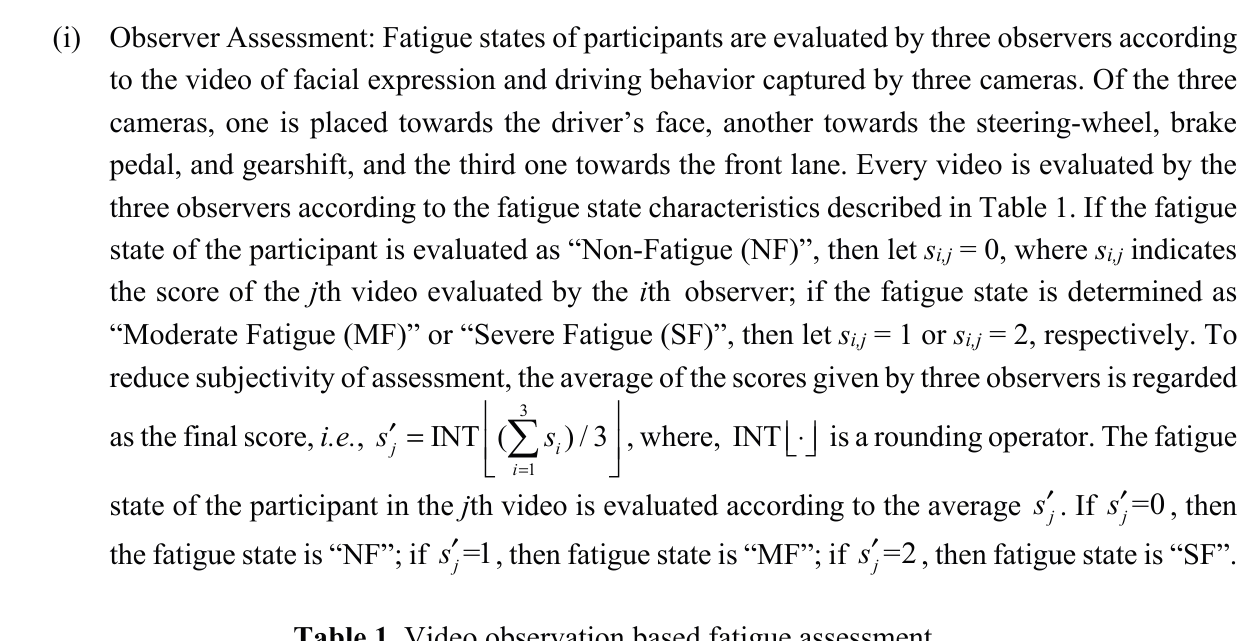
Table 1. Video observation based fatigue assessment. Fatigue State Description State